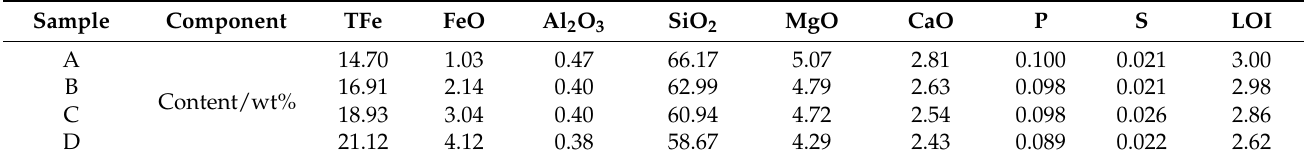
Table 3. The chemical multi-element analysis of sample A, B, C and D.